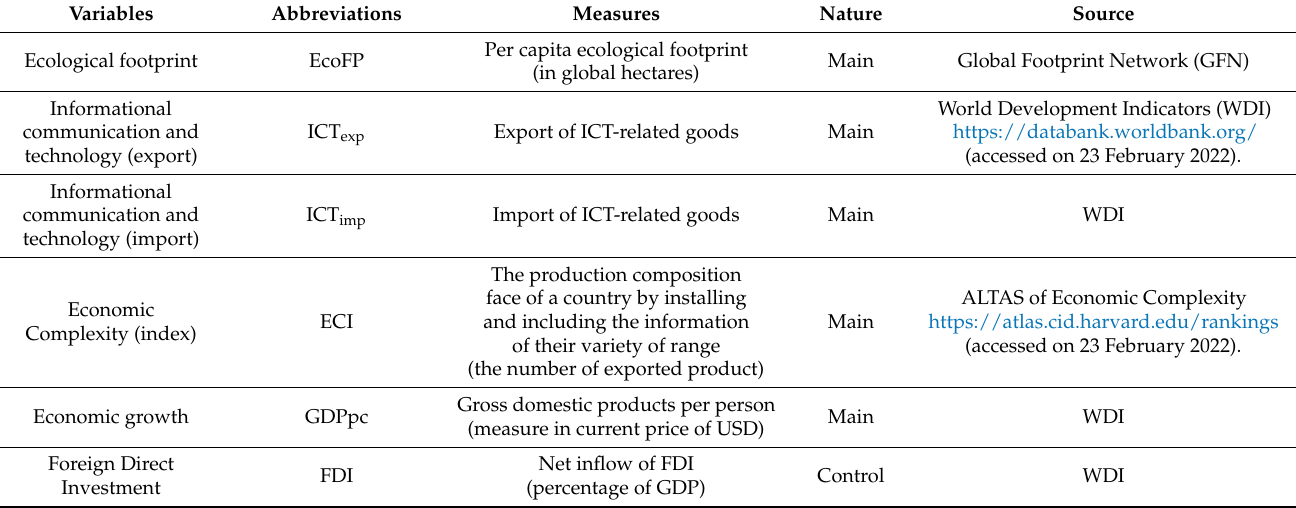
Table 1. Acronym, measuring unit, nature, and source of the